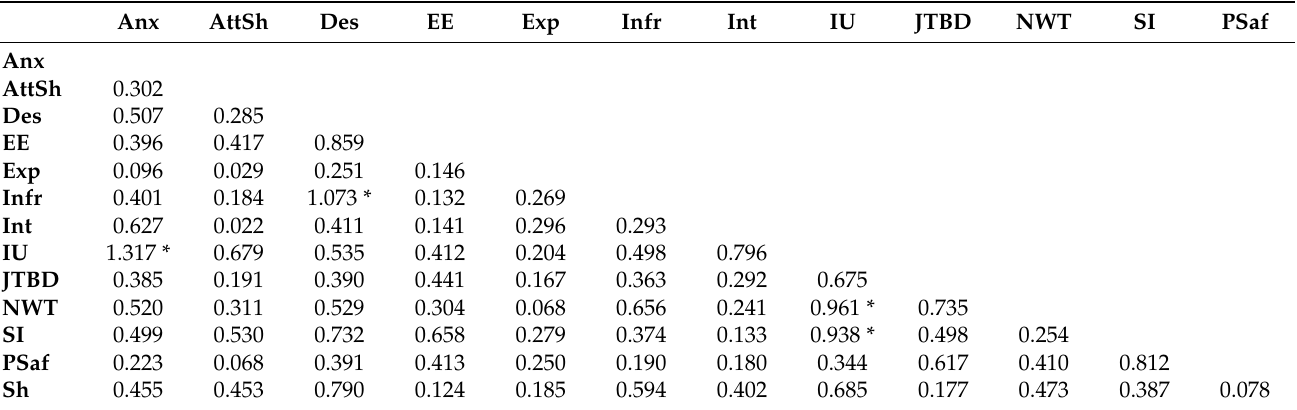
Table A4. Discriminant validity: Divergent validity Heterotrait–Monotrait ratios (HTMT).